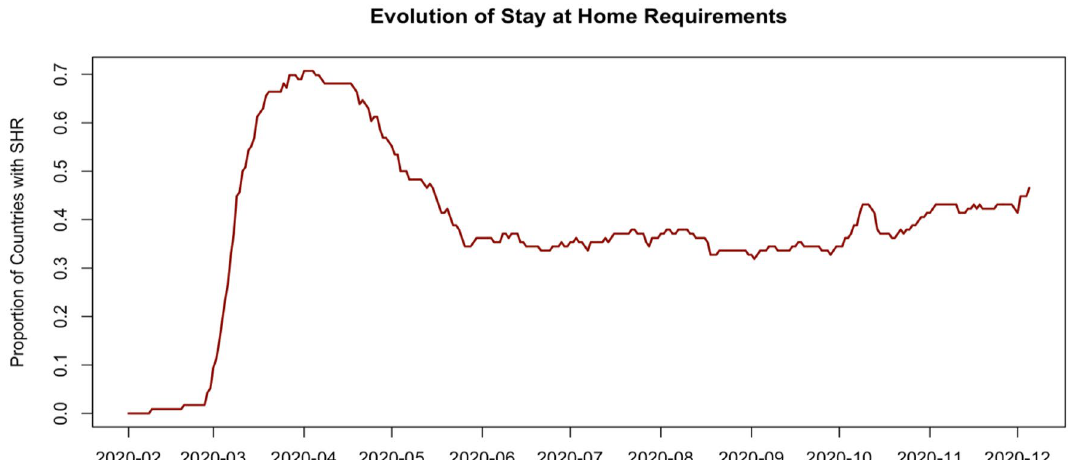
Figure 2. The proportion of countries with a lockdown. The daily fraction of countries that have an active stay- at-home order for its general population (n = 116 countries).